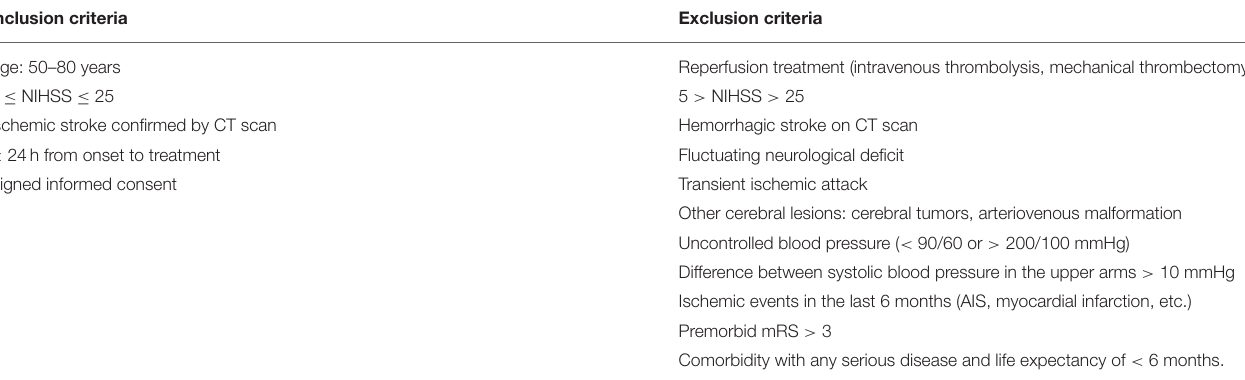
TABLE 1 | The inclusion and exclusion